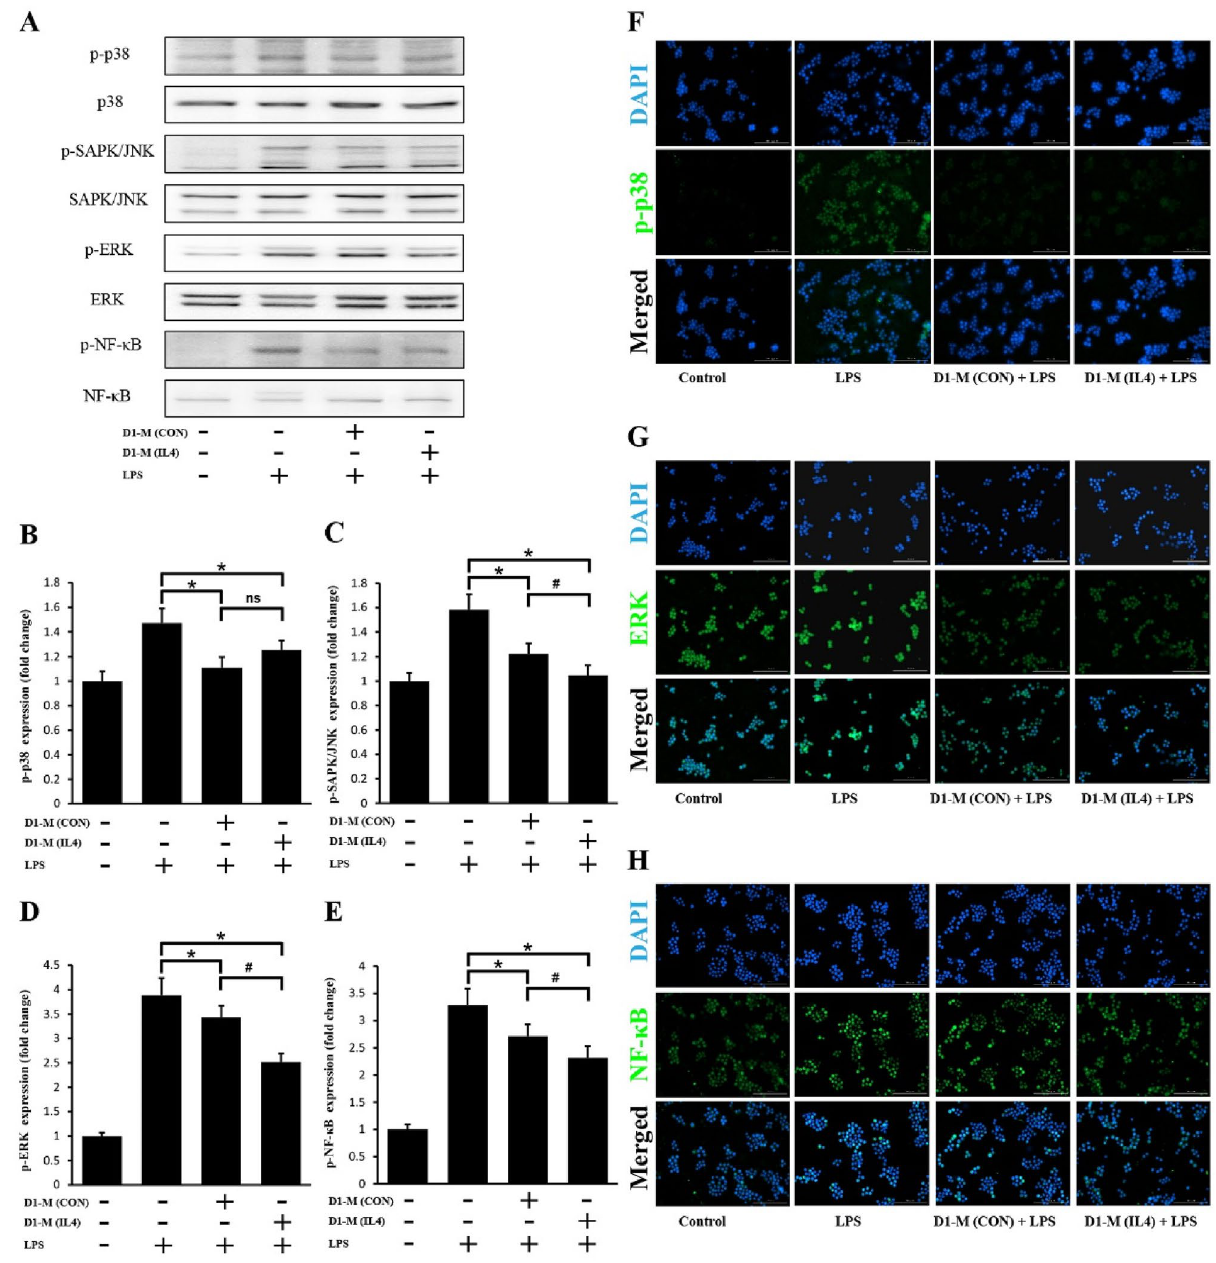
Figure 3. MSC-CM treatment suppressed the LPS-stimulated phosphorylation of p38 MAPK, SAPK/ JNK, ERK1/2, and NF-κB ( A ). Representative western blots of anti-p38 and anti-p-p38 ( B ), anti-SAPK/ JNK and anti-p-SAPK/JNK ( C ), anti-ERK1/2 and anti-p-ERK1/2 ( D ), and anti-NF-κB and anti-p-NF-κB ( E ) antibody detection in LPS-stimulated RAW264.7 cells with or without MSC-CM treatment for 24 h. For immunofluorescence analysis, RAW264.7 cells were pretreated with MSC-CM for 24 h and then stimulated with LPS (200 ng/mL) for 1 h. Fluorescence images (× 200) of RAW264.7 cells immunostained for p-p38 (green) ( F ), p-ERK1/2 (green) ( G ), and p-NF-κB (green) ( H ) with DAPI counterstain (blue) as control. The MAPK phosphorylation signal was increased by LPS stimulation and suppressed by MSC-CM pretreatment. No such changes were observed for the JNK signal (Supplementary Fig. 2). The results are representative of three separate experiments. The quantitative data represent the average values of three separate experiments ( * P < 0.05 compared to LPS treatment without MSC-CM; # P < 0.05 compared between MSC-CM-treated groups; ns, no statistical difference between MSC-CM-treated groups, P > 0.05). The Fig. 3 A was cropped to improve the clarity and conciseness of the presentation, and the full-length blots/gels are presented in Supplementary file. MSC-CM, mesenchymal stem cell-conditioned media; D1-M (CON), D1 cell media; D1-M (IL4), D1 cell media stimulated with IL4; LPS, lipopolysaccharide; SAPK/JNK, stress-activated protein kinase/Jun-amino-terminal kinase; ERK, extracellular signal-regulated kinase; NF-κB, nuclear factor